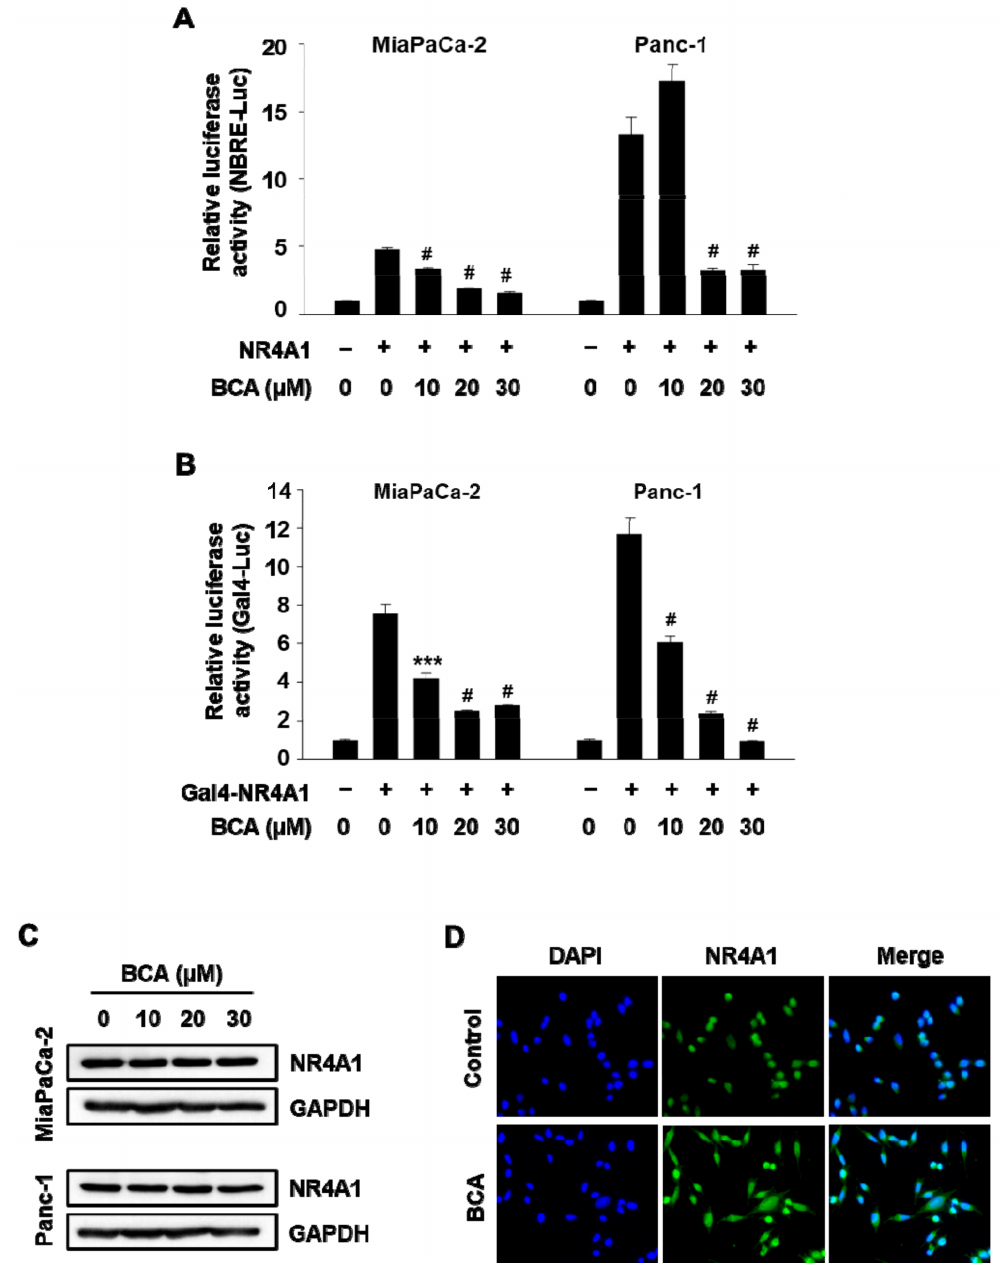
Figure 1. Broussochalcone A (BCA) inhibits transactivation of the orphan nuclear receptor 4A1 (NR4A1) in pancreatic cancer cells. ( A ) Cells were cotransfected with NBRE-Luc (25 ng) and Flag-NR4A1 (12.5 ng) for 5 h, and then treated with various concentrations of BCA for 18 h. # p < 0.001 vs. dimethyl sulfoxide (DMSO) + NR4A1. ( B ) Cells were cotransfected with Gal4-RE-Luc (25 ng) and 5 ng of Gal4-NR4A1 for 5 h, and then treated with BCA for 18 h. Luciferase activity (relative to β -galactosidase) was determined, and the corresponding empty vector was used as a control. The results are presented as means ± SEM (standard error of the mean). *** p < 0.005 and # p < 0.001 vs. DMSO + Gal4-NR4A1. ( C ) Cells were treated with BCA for 24 h, and whole cell lysates were analyzed by Western blot analysis. Glyceraldehyde 3-phosphate dehydrogenase (GAPDH) was used as a loading control. ( D ) Subcellular localization of NR4A1. MiaPaCa-2 cells were treated with either DMSO or BCA 15 µ M for 3 h, and endogenous NR4A1 was stained and visualized as described in the Section